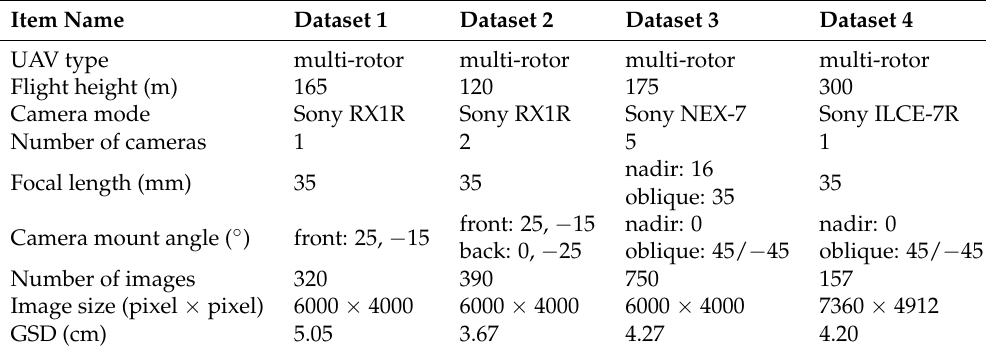
Table 4. Detailed information for data acquisition of the four